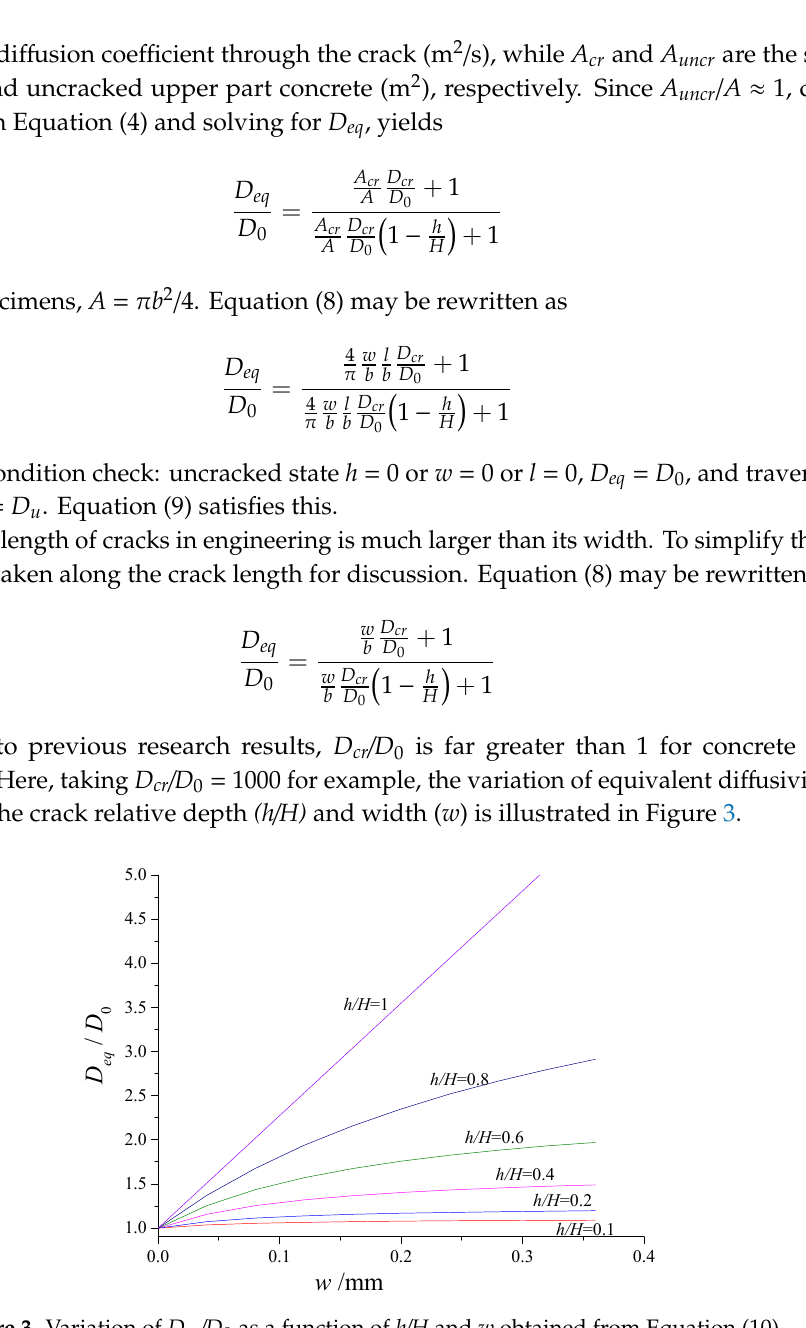
Figure 3. Variation of D eq /D 0 as a function of h/H and w obtained from Equation (10).